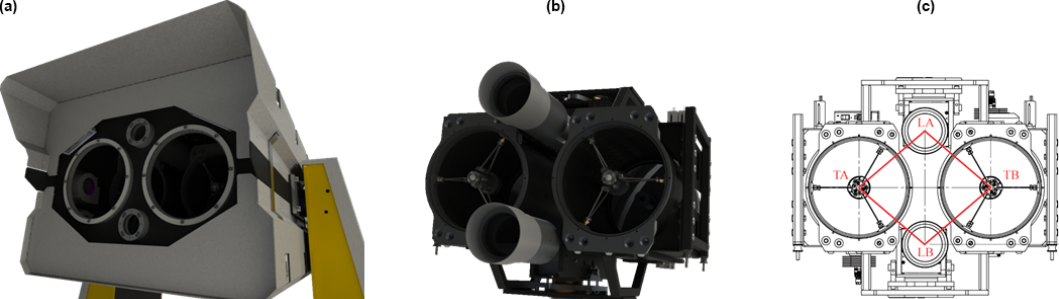
Figure 3. The lidar head. (a) Cover of the lidar head, showing the windows in front of the two lasers and the two telescopes. (b) Photorealistic image of the internal parts of the head, showing the lasers and their beam expanders, the telescopes, and the rest of the detection units. (c) Front view of the head, showing the diamond-shaped layout of the lasers (LA and LB) and telescopes (TA and